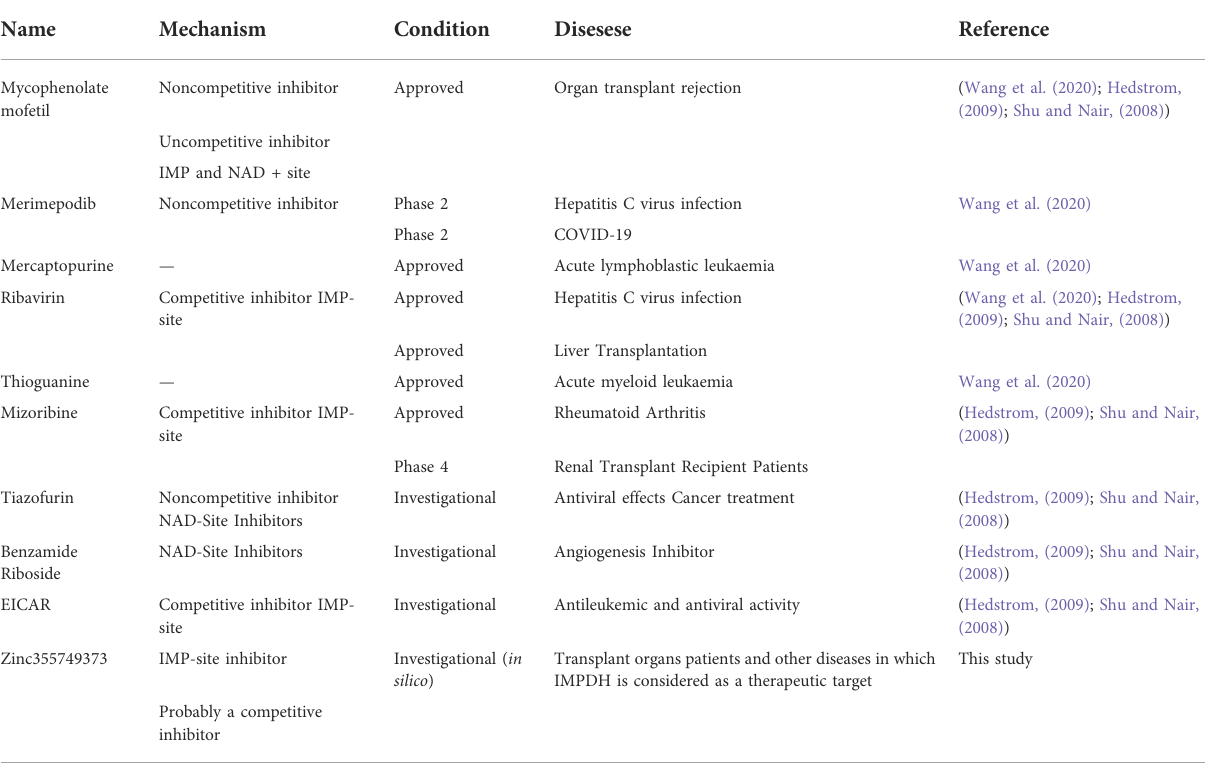
TABLE 6 Some of the most important human IMPDH inhibitors.